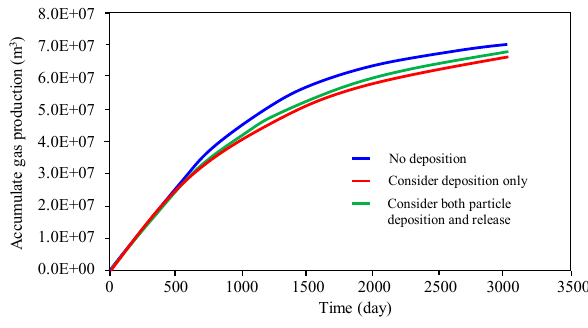
Figure 9. Accumulated gas production.